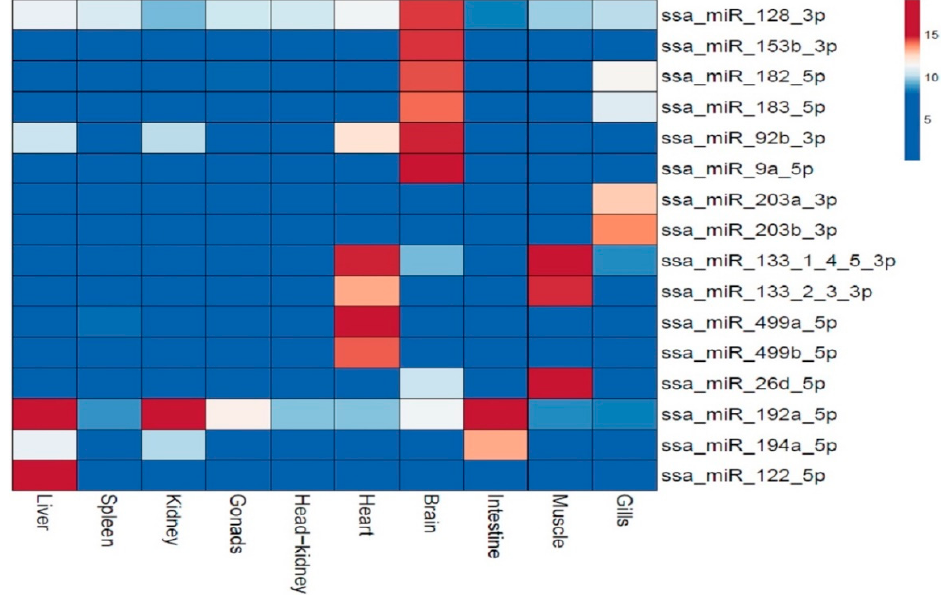
Figure 5. The heatmap illustrates the predominant expression of 16 mature miRNAs in particular tissues. The tissues compared are given at the bottom of the columns, while the miRNAs are given in the horizontal rows to the right. Four of these miRNAs (ssa-miR-9a-5p, ssa-miR-499a-5p, ssa-miR-192a-5p and ssa-miR-122-5p) were also analyzed by RT-qPCR (see Table 2). The expression values (log2) of the miRNAs are depicted in the color scale. Very little or no expression is shown in dark blue, while other colors indicate increased expression (10–100 times) with dark red color as those with the higher expression.